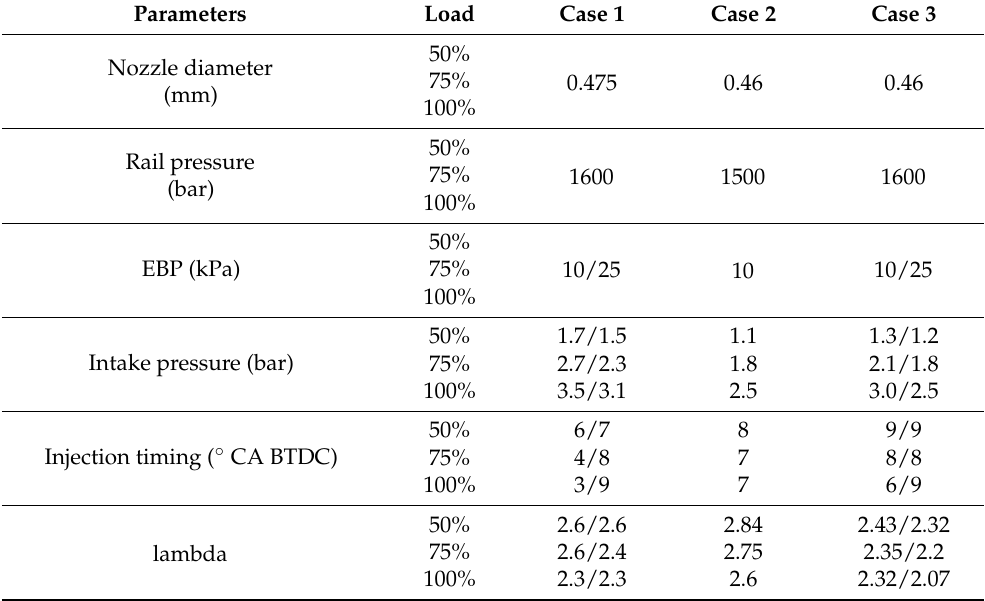
Table 2. Parameter details of the three